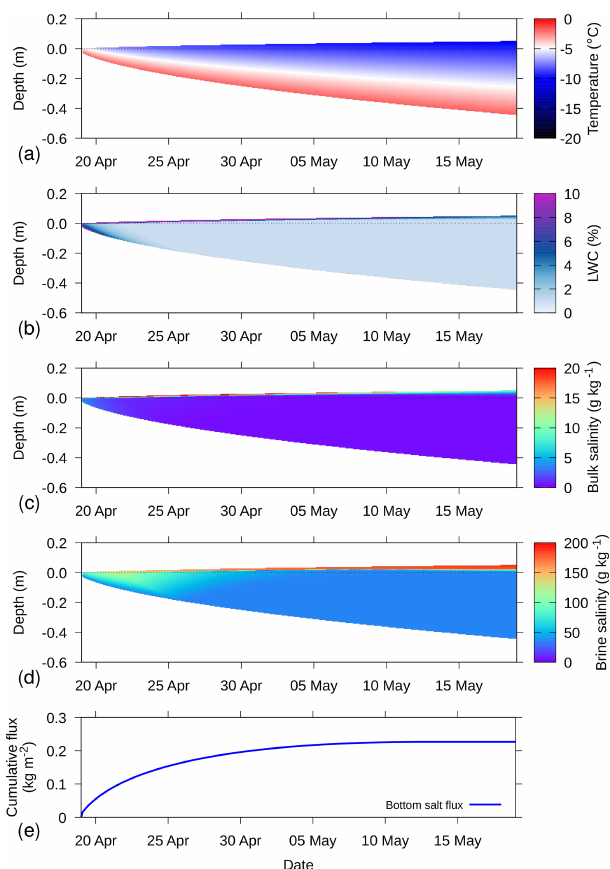
Figure 13. Simulation for ice growth of thin ice, for (a) temperature, (b) LWC, (c) bulk salinity, (d) brine salinity, and (e) cumulative salt flux at the bottom of the sea ice. In (a–d) , the depth on the y axis is defined relative to sea level. An increasing cumulative flux denotes inflow and vice